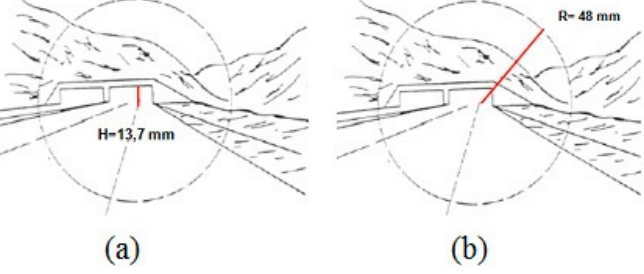
Figure 1. Basis of the L20 cone ( a ) and its radius ( b ) on a picture of the portal gate under a not very high mountain (adapted from Reference [1], [35]).